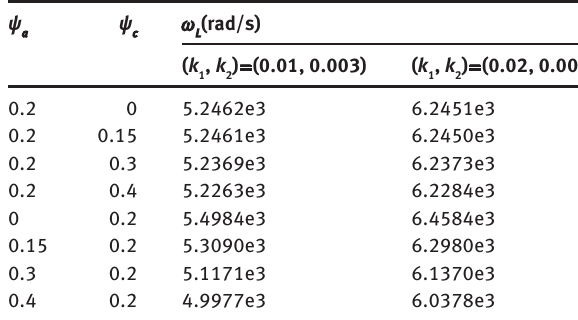
Table 2: Effects of particle volume fraction, fibre volume fraction, and elastic foundations on the natural frequencies of the three- phase polymer composite cylindrical panel.